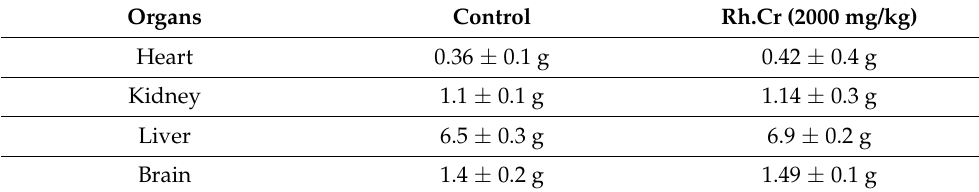
Figure 8. Histopathological slides showing the effect of Rumex hastatus crude extract (Rh.Cr), n-hexane (Rh.n-Hex), ethyl acetate (Rh.ETAC), an aqueous fraction (Rh.Aq), rutin and omeprazole in ethanol-treated rats gastric tissues using hematoxylin and eosin staining histopathological technique. Bar 50 µm, magnification 40×. Table 8. Effect of Rumex hastatus crude extract (Rh.Cr) against different organs weight of rats.